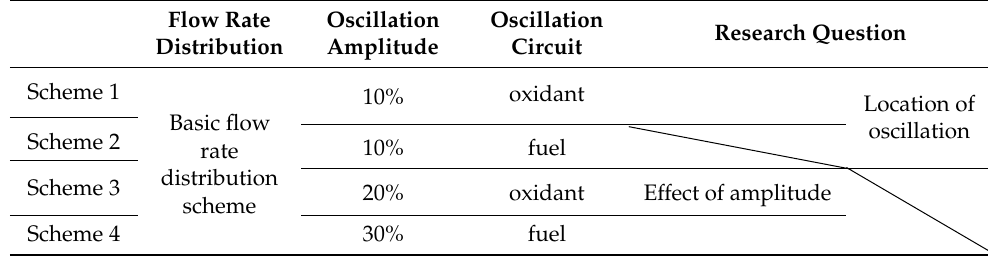
Table 2. Settings for Schemes 1 to 4.